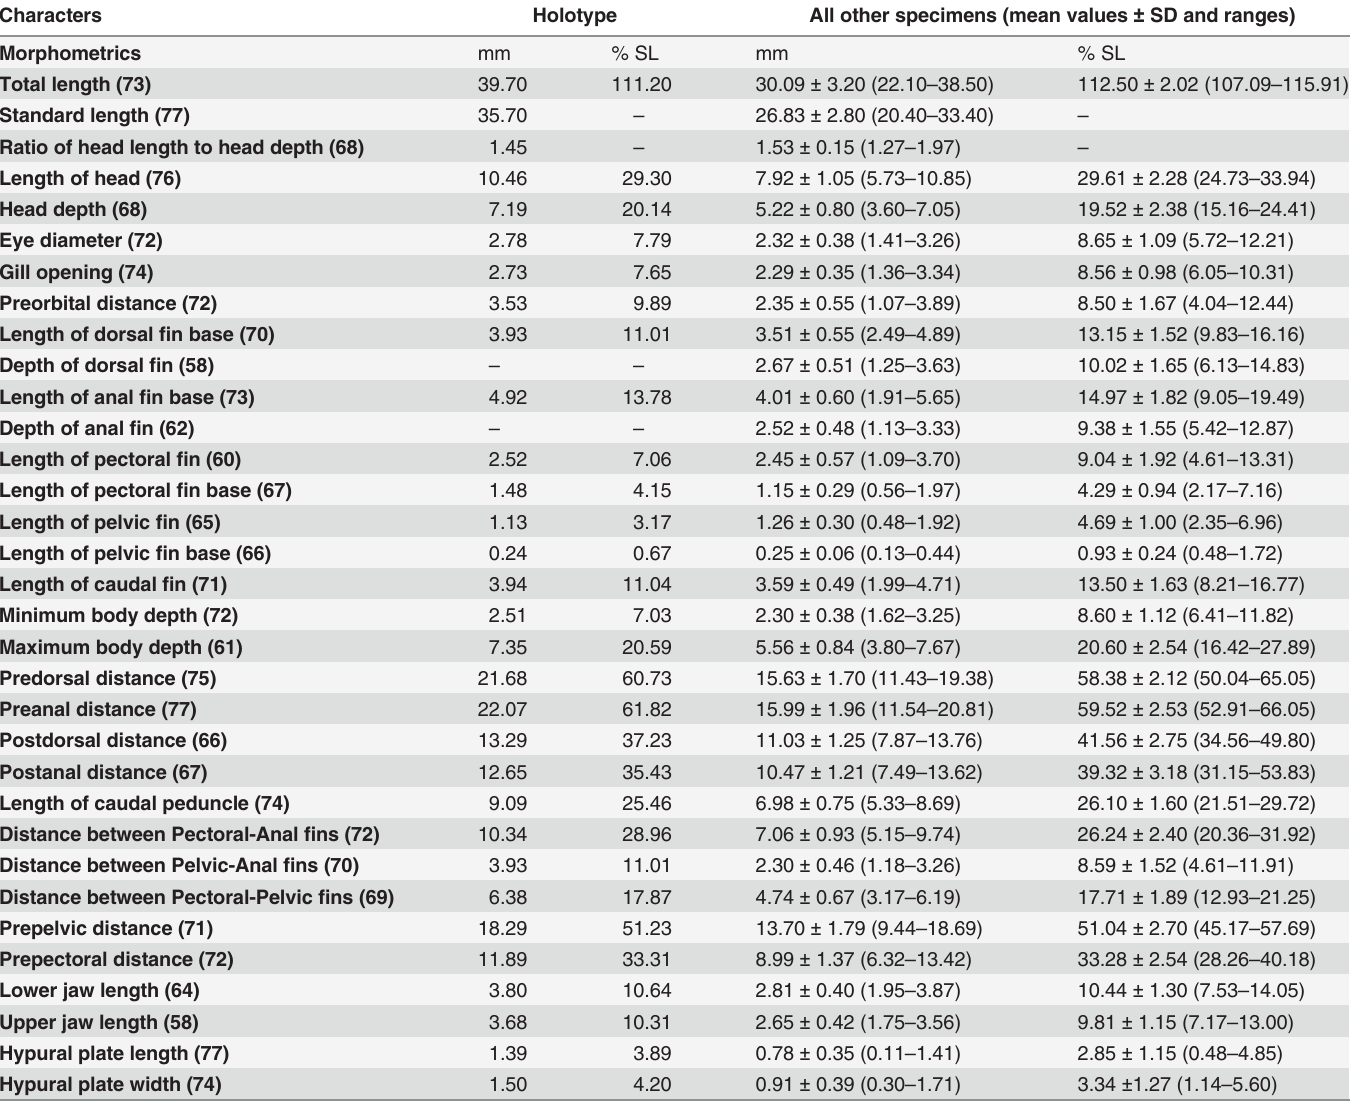
Table 1. Morphometric characters (given in mm and in % of SL) for † Kenyaichthys kipkechi sp. nov. based on the holotype (1209a/b´04) and all other